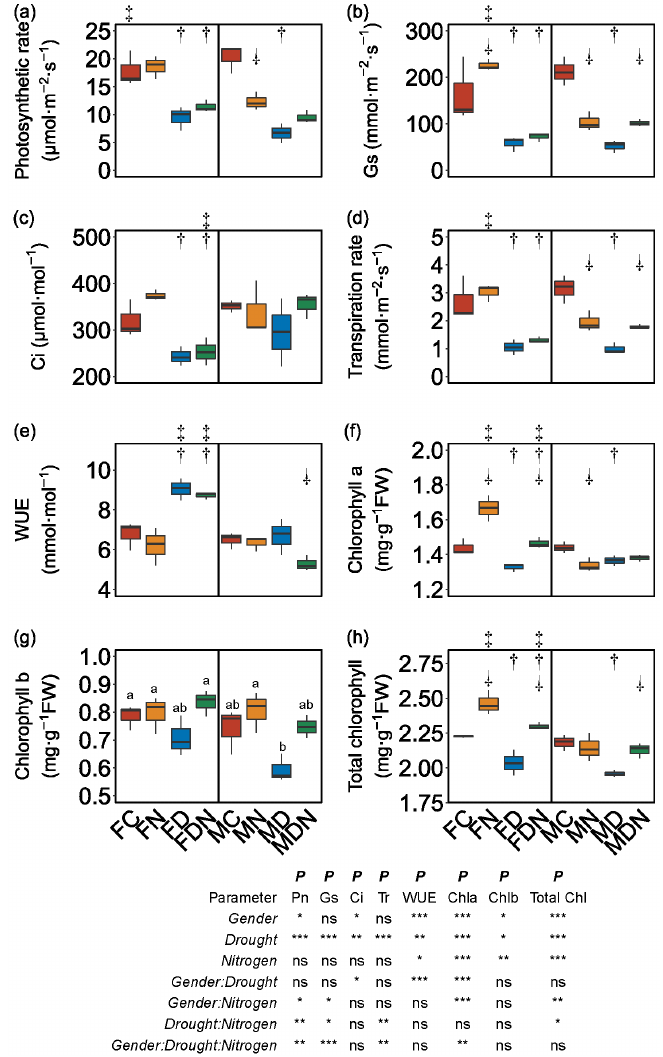
Figure 4. The photosynthetic gas exchange and pigments of S. myrtillacea cuttings ( n = 3). ( a ) Net photosynthetic rate; ( b ) stomatal conductance; ( c ) intercellular carbon dioxide concentration; ( d ) transpiration rate; ( e ) water use efficiency; ( f ) Chla; ( g ) Chlb; ( h ) total Chl. F, females; M, males; C, control; N, N deposition; D, drought; DN, drought and N deposition. The double dagger (‡) indicates simple effect of gender, the dagger (†) indicates simple effect of drought, and the inverted dagger ( ⸸ ) indicates simple effect of N deposition. Different letters among groups indicate significant differences (Tukey test, p < 0.05). Asterisks denote significant differences: ***, p < 0.001; **, p < 0.01; *, p < 0.05.